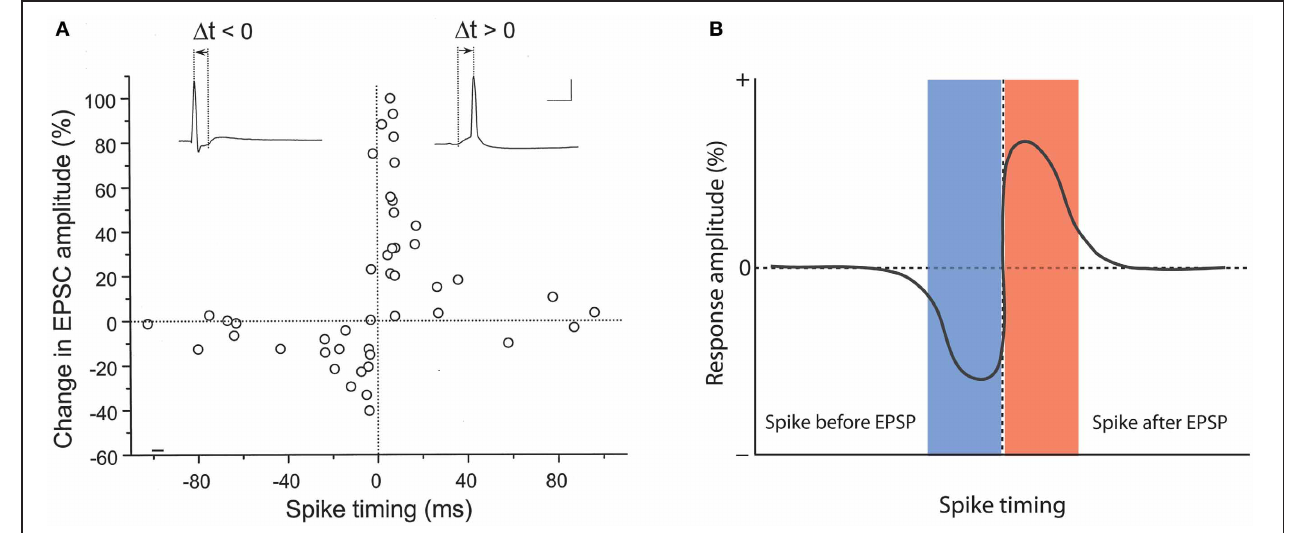
the EPSP and the spike peak (see traces on top). Scale bars: 50mV and 10ms. (B) Model scheme for Hebbian STDP. LTD results when the spikes precede the EPSPs, whereas LTP is induced when the EPSPs are evoked before spike onset. (A) is taken from Bi and Poo (1998). Copyright 1998 by the Society for